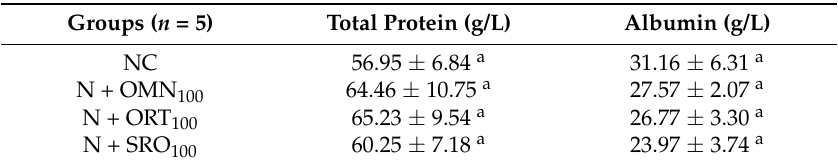
Table 2. Effect of aqueous extracts of Musa acuminata peels on serum total protein and albumin concentration in rats.